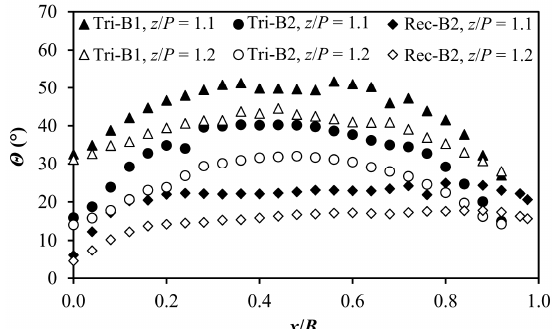
Figure 13. Variations of Θ along the PKW sidewall centerline ( H o / P = 0.7).